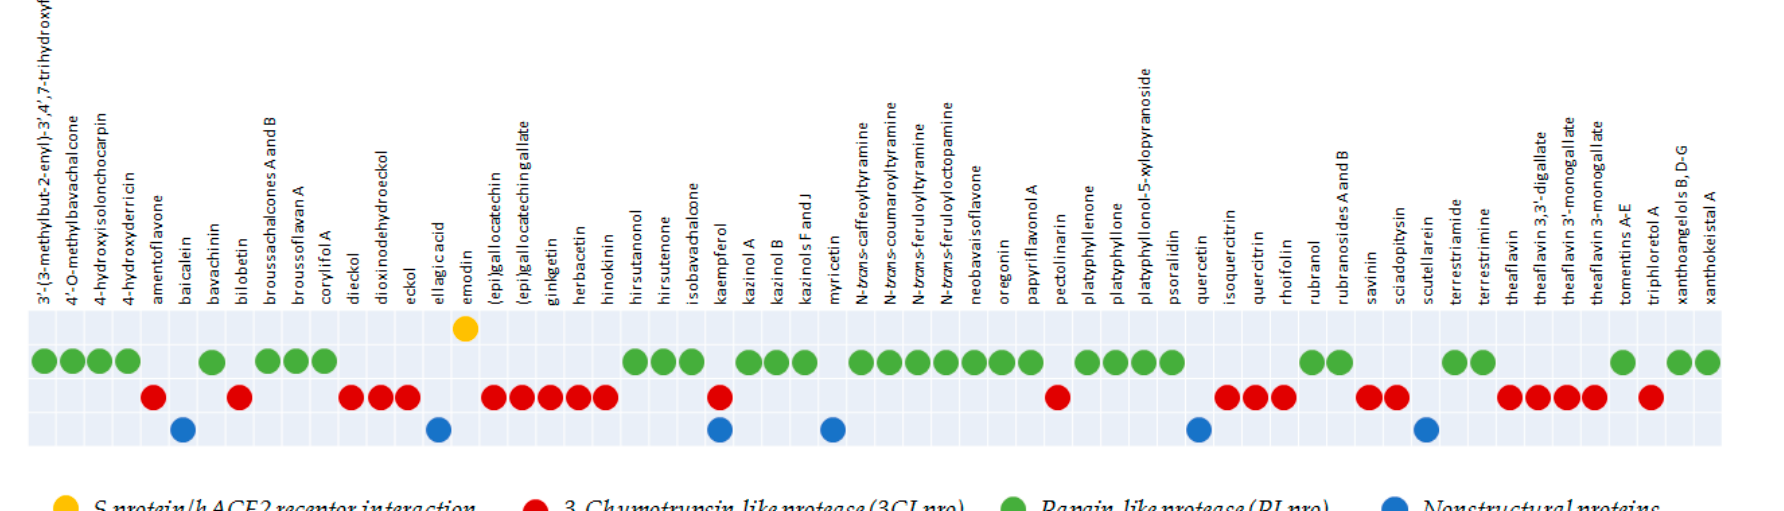
Figure 9. A summarizing picture of the different compounds able to interfere with the viral infection, acting vs. four main targets, highlighted in different colors.